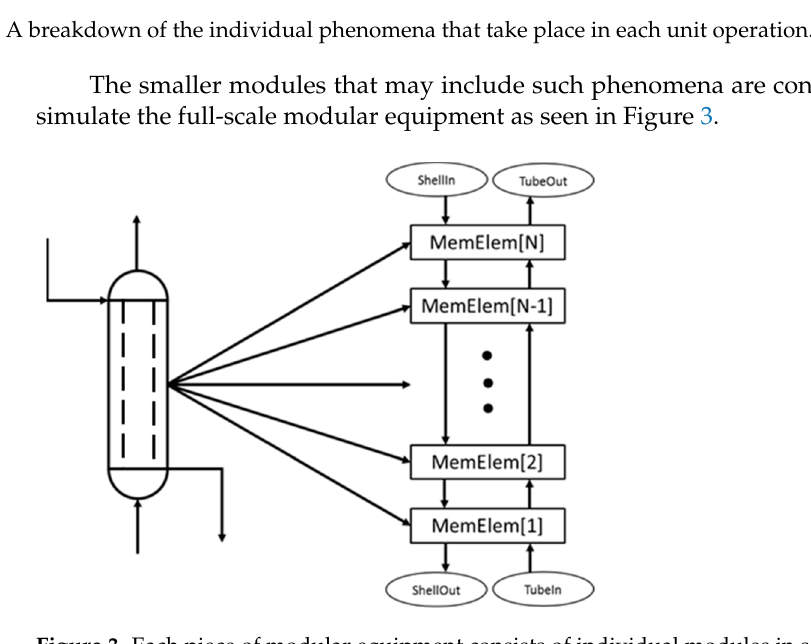
Figure 3. Each piece of modular equipment consists of individual modules in series. These modules have been fully developed in AVEVA Process Simulation and can be a heat exchanger, reactor, membrane separator, or membrane reactor.